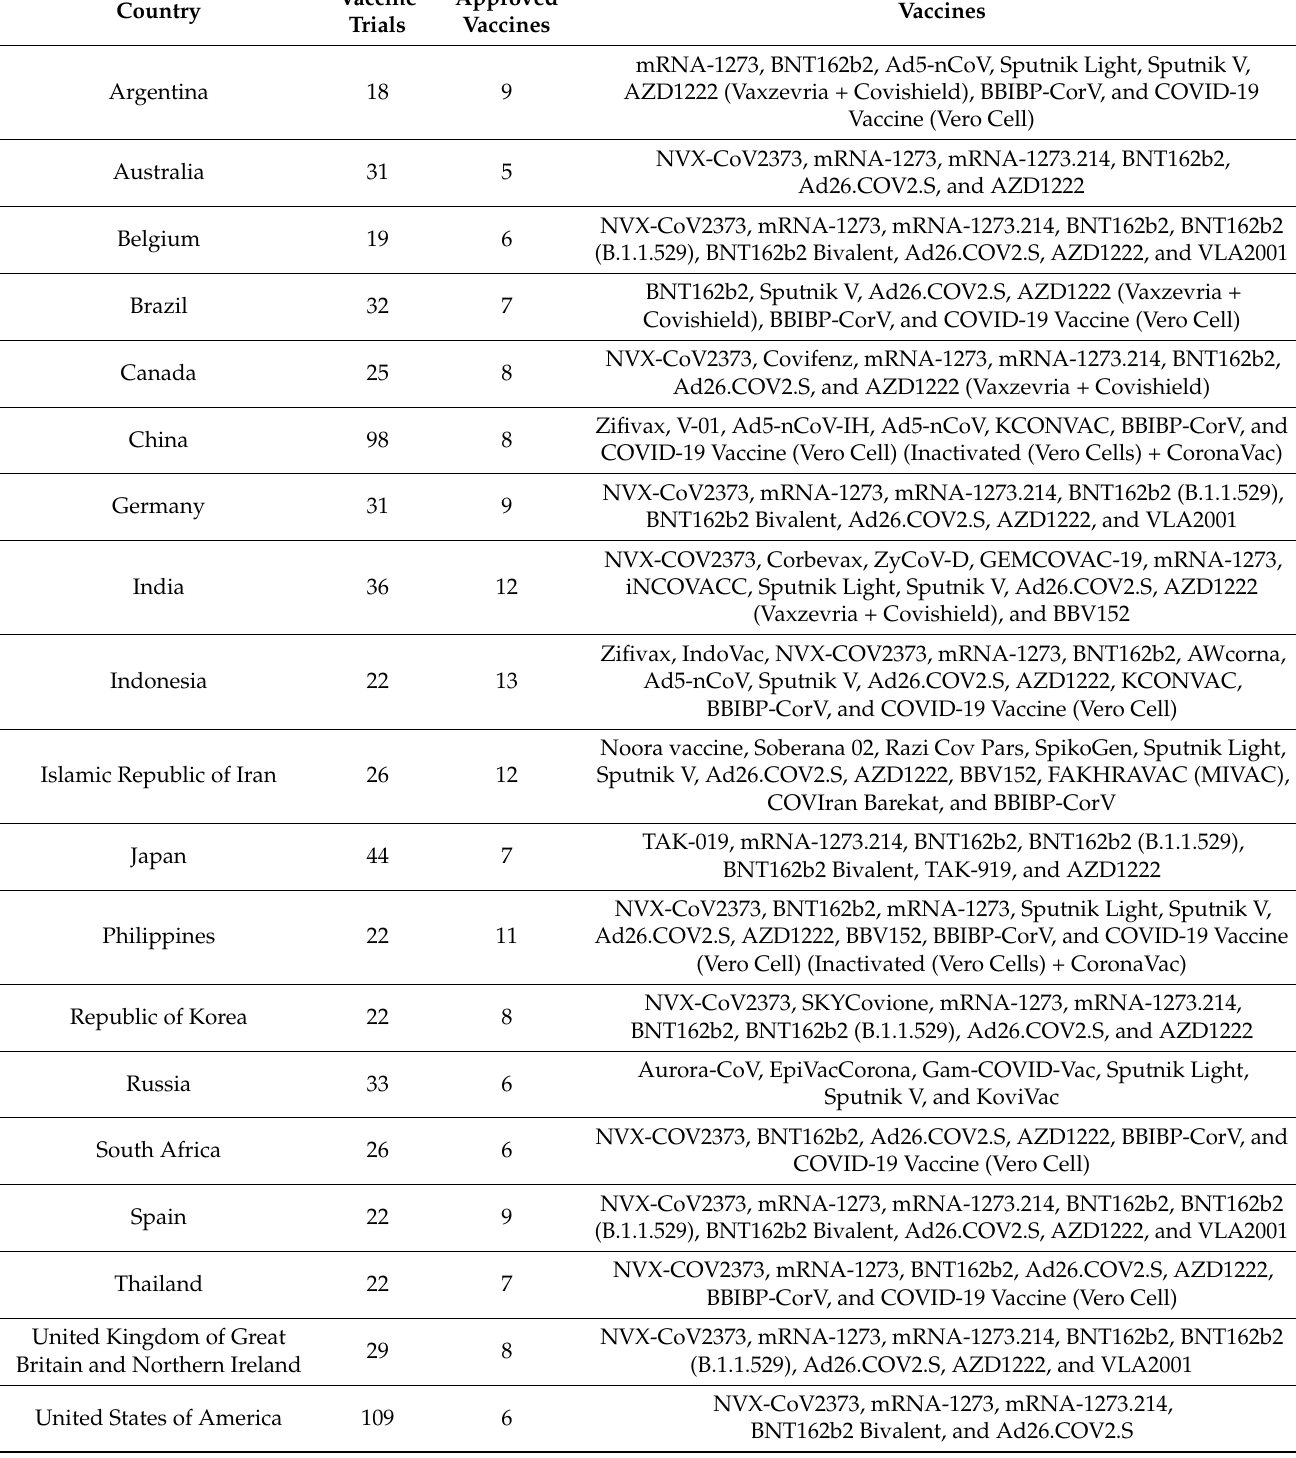
Table 1. Countries with the most vaccine research and/or the greatest numbers of vaccine registrations [8].